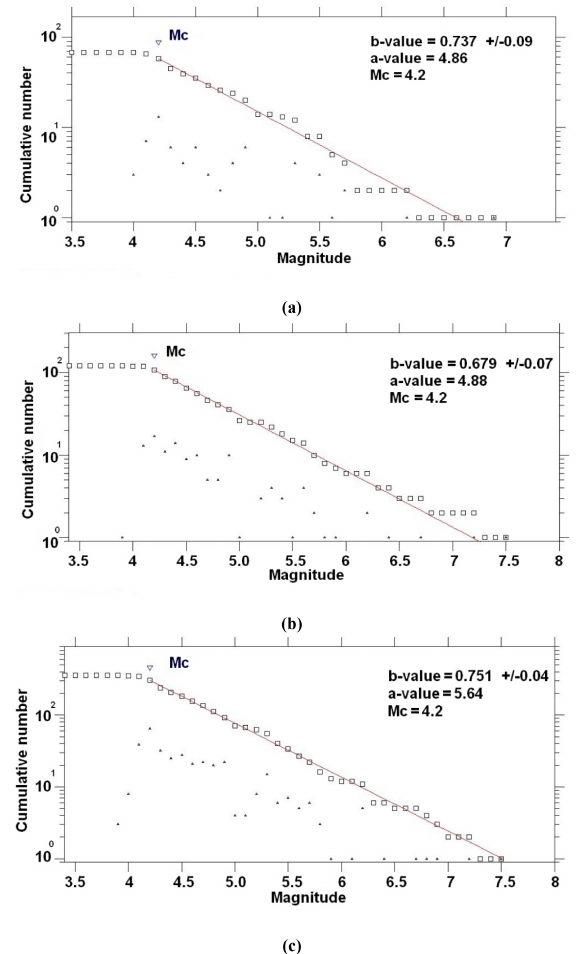
Figure 3. Estimated magnitude recurrence parameters for (a) Zone 1, (b) Zone 2, and (c) Zone 3.